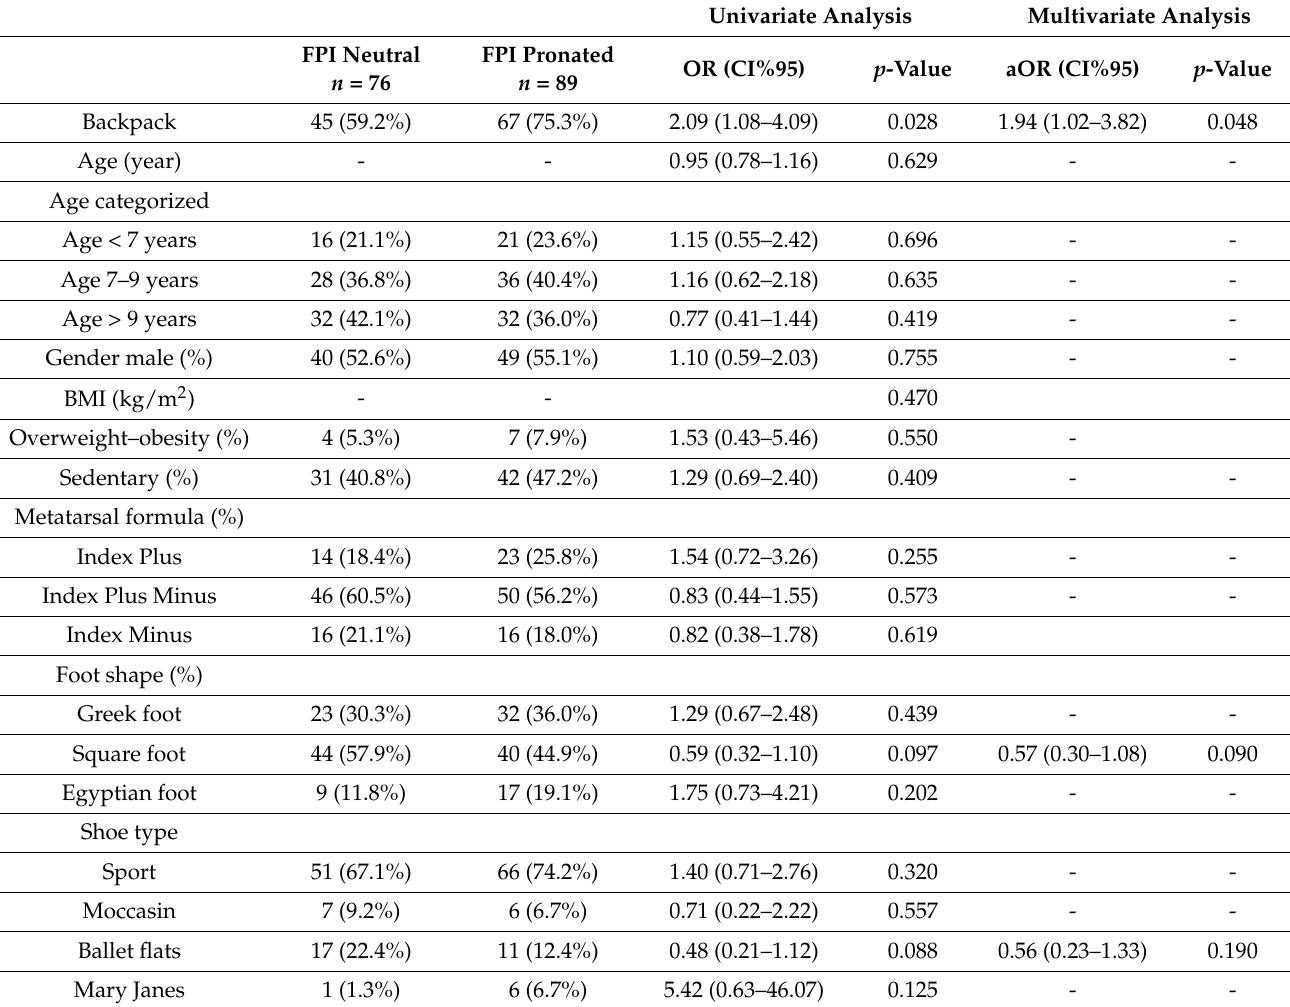
Table 3. Predictors of individuals with pronated foot not developing a neutral foot